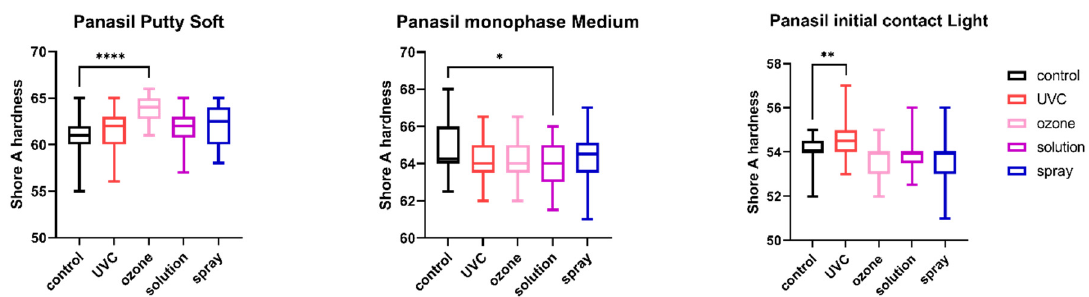
Figure 6. Shore A hardness of A-silicones (Panasil Putty Soft, Panasil monophase Medium, and Panasil initial contact Light) after disinfection using various methods; * p < 0.05, ** p < 0.01, and **** p < 0.0001 for the comparison between the study (disinfected) groups and the control (nondisinfected) group.